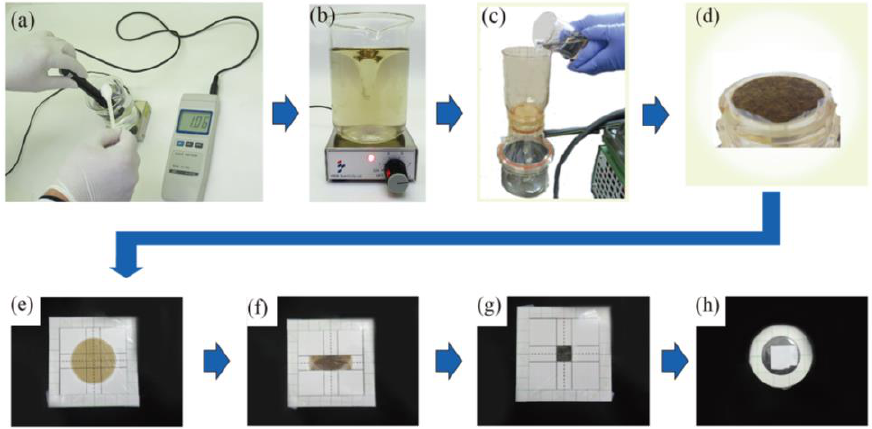
Figure 2. Outline of the sample preparation process. ( a ) Addition of sodium perchlorate monohydrate until the salinity meter reading reached 3%, followed by addition of the GO dispersion, and adjustment of the pH to 6. ( b ) Stirring of the sample solution. ( c ) Collection of GO using a membrane filter. ( d ) The membrane filter bearing the collected GO. ( e ) Placement of the GO collection membrane filter onto the lined mount. ( f ) Folding of the filter into 1/3 of its size in the vertical direction. ( g ) Folding of the filter into 1/3 of its size in the horizontal direction. ( h ) Sealing using a circular sealing